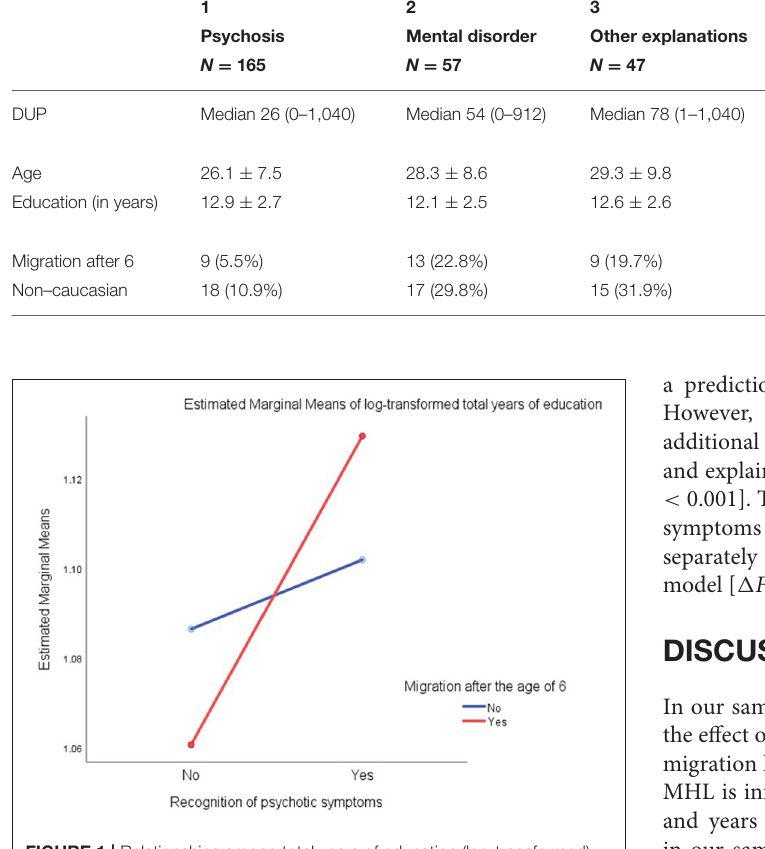
FIGURE 1 | Relationships among total years of education (log-transformed), recongnition of psychotic symptoms, and migration experience after the age of six generated by test of between subjects effects with